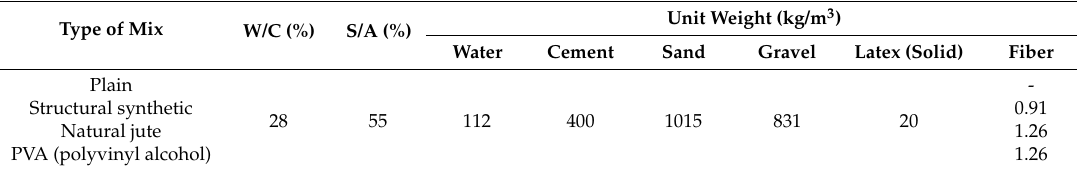
Table 6. Mix proportions of roller-compacted latex-modified fiber-reinforced rapid-hardening-cement concrete (RCLMFRRHCC) for pavement repair.